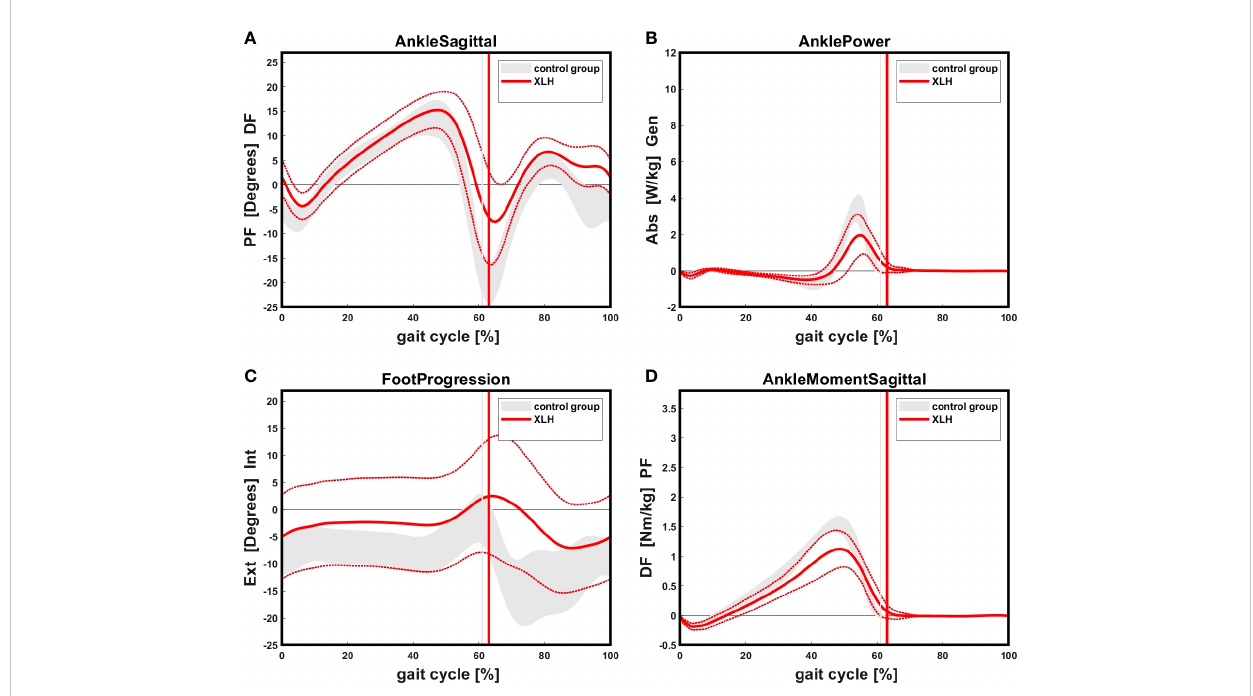
FIGURE 8 (A) : XLH patients showed reduced ankle plantar fl exion in initial swing as well as in terminal swing an increased dorsi fl exion compared to the control group. Solid (red) line indicates the XLH group (+ 1 SD), gray band indicates the control group (+ 1 SD). Positive values indicate dorsi fl exion of the ankle, negative values indicate plantar fl exion. (B) : XLH patients showed reduced ankle power during push-off phase compared to the control. (C) : XLH patients presented with increased internal foot progression during stance and swing phase compared to the norm. The standard deviation showed a high variability. Positive values indicate internal, negative values indicate external rotation of the foot. (D) : Patients with XLH showed reduced maximum sagittal ankle plantar fl exion moment in the terminal stance phase.